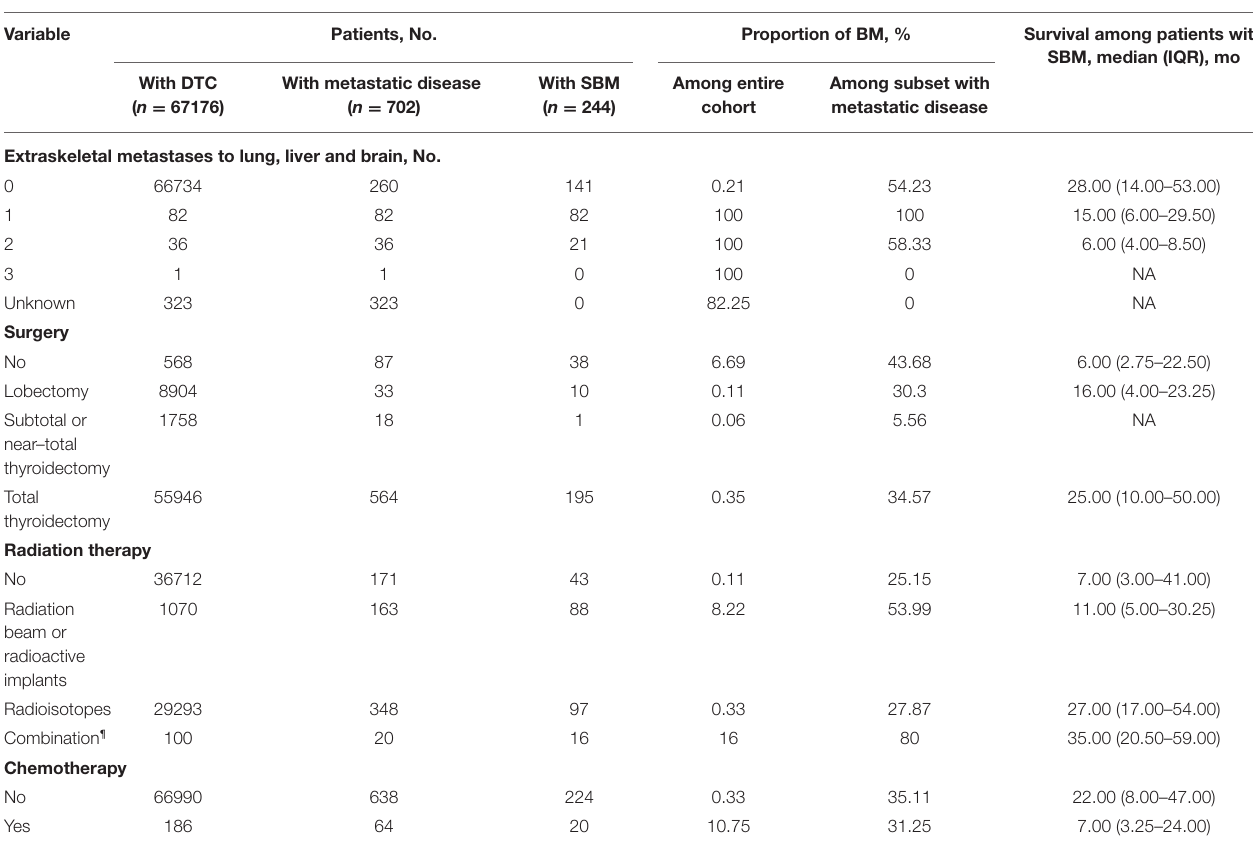
Supplementary Table S1 . Incidence rates of SBM in